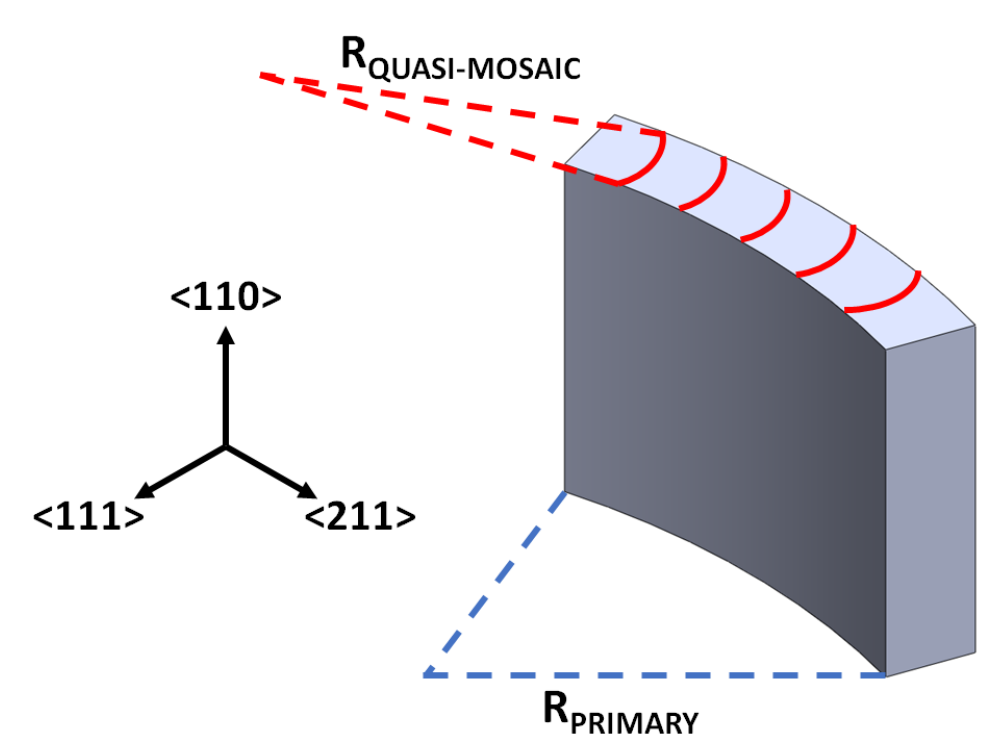
Figure 9. sketch of quasi-mosaic bending